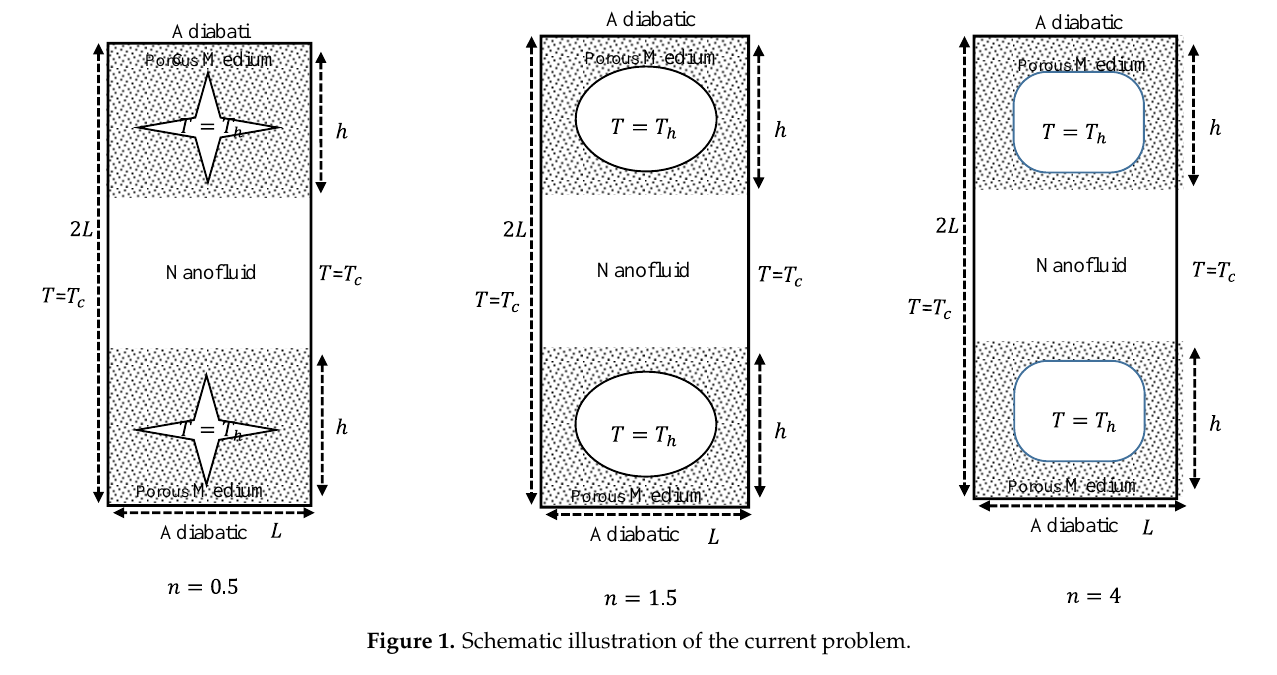
Figure 1. Schematic illustration of the current problem.